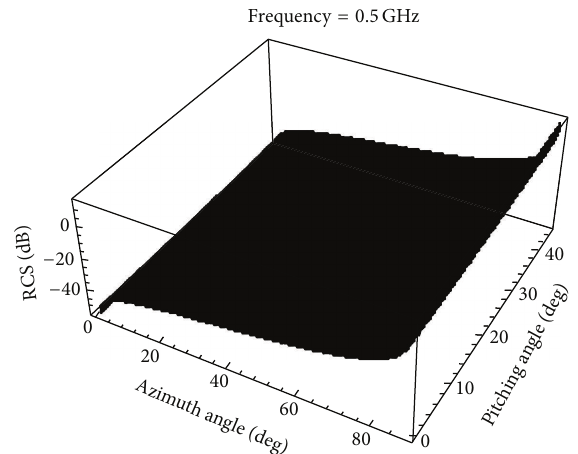
Figure 10: Backscattered RCS for an elliptical cylinder for 𝜃, 𝜑 of ̂𝑚 = 128.